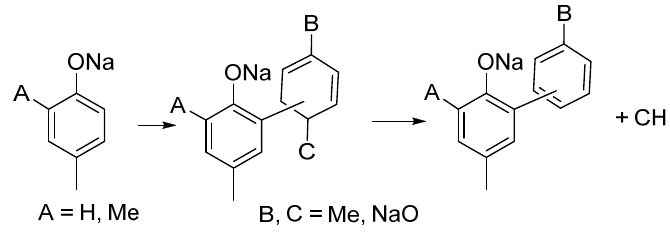
16 of 21 Figure 10. Q-TOF spectrum of sodium p -cresolate collected at 495 °C.